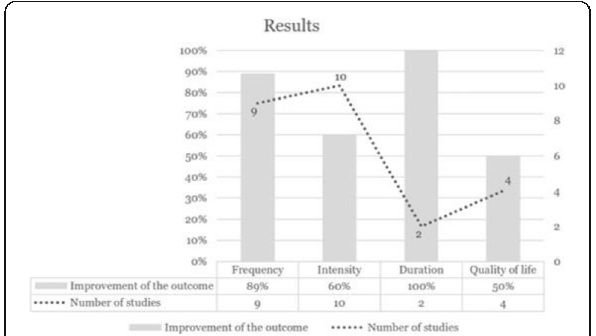
Fig. 1 (abstract P11). See text for